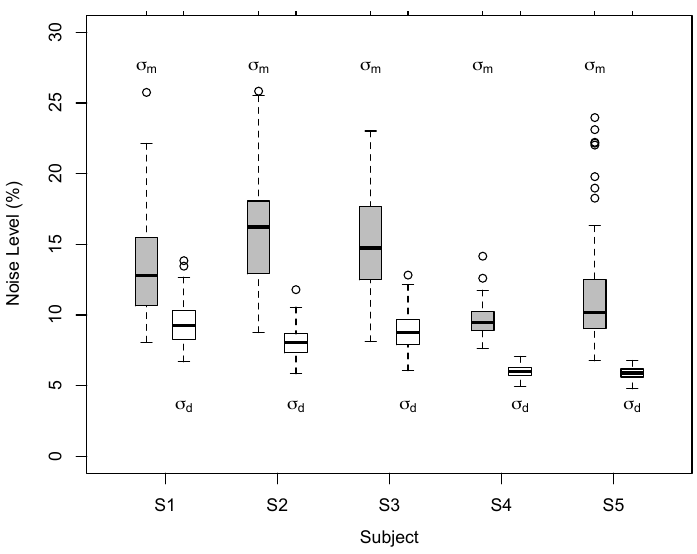
Figure 7. Individual noise estimates of BVN2 in Exp. 1. Monocular motion ( σ m ) and dynamic depth ( σ d ) estimates for Observer S1 to S5 from bootstrapped data. Thick horizontal lines denote medians, boxes the second to third quartile with error bars (whiskers) extending 1.5 times of the interquartile range. Open circles denote outliers. All pairwise differences between individual motion and depth noise estimates were statistically significant ( p < 0.002, two-tailed t -test,